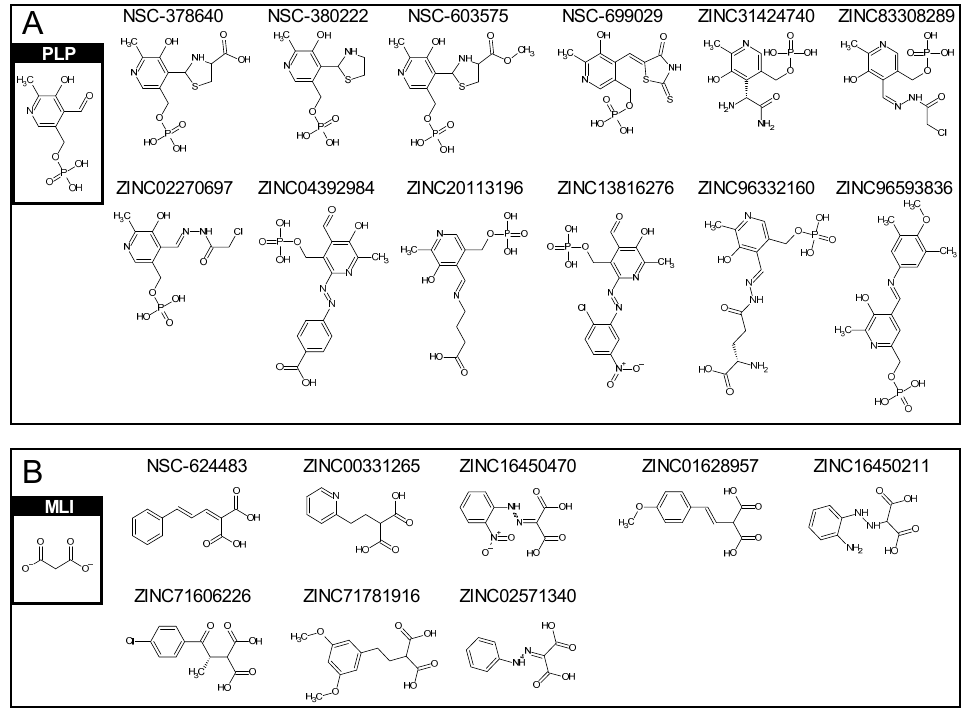
Figure 3. The compound IDs and their 2D structures of ( A ) PLP ‐ like compounds and ( B ) MLI ‐ like Figure 3. ThecompoundIDsandtheir2Dstructuresof( A )PLP-likecompoundsand( B compounds.